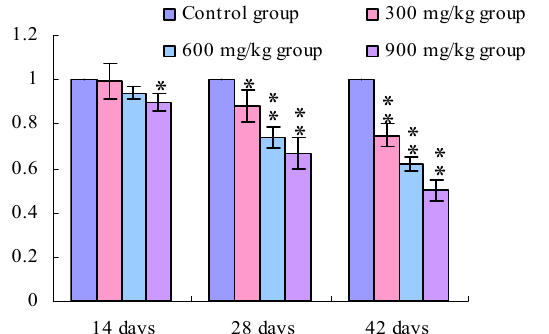
Figure 1. The TLR2-2 mRNA expression levels in the duodenal mucosa in broilers.